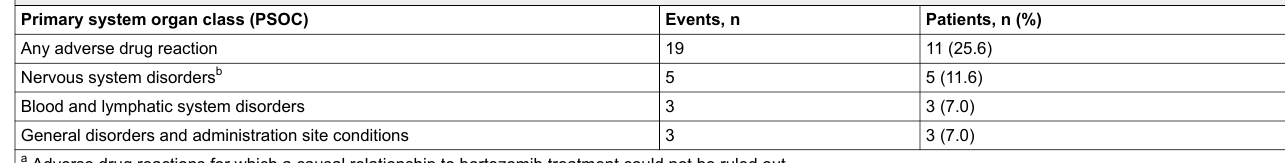
TFI, treatment-free interval.